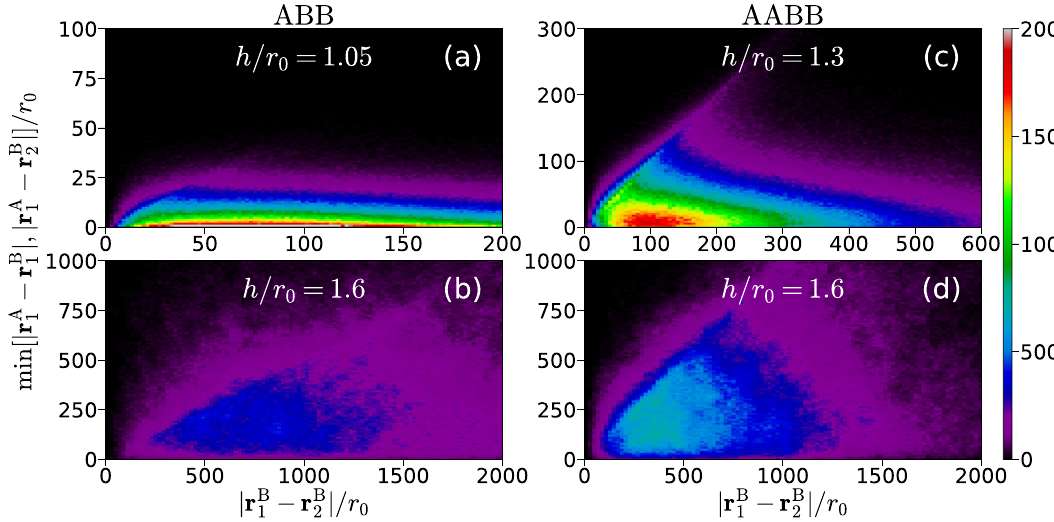
Figure 3. Spatial structure of the ground-state for ABB trimer ( a , b ) and AABB tetramer ( c , d ) for different values of the interlayer distance. The distance between two dipoles in the same layer is plotted in the horizontal axis and the minimum distance between dipoles in different layers is shown in the vertical axis. Plots created using Matplotlib (version 3.3.3) 40